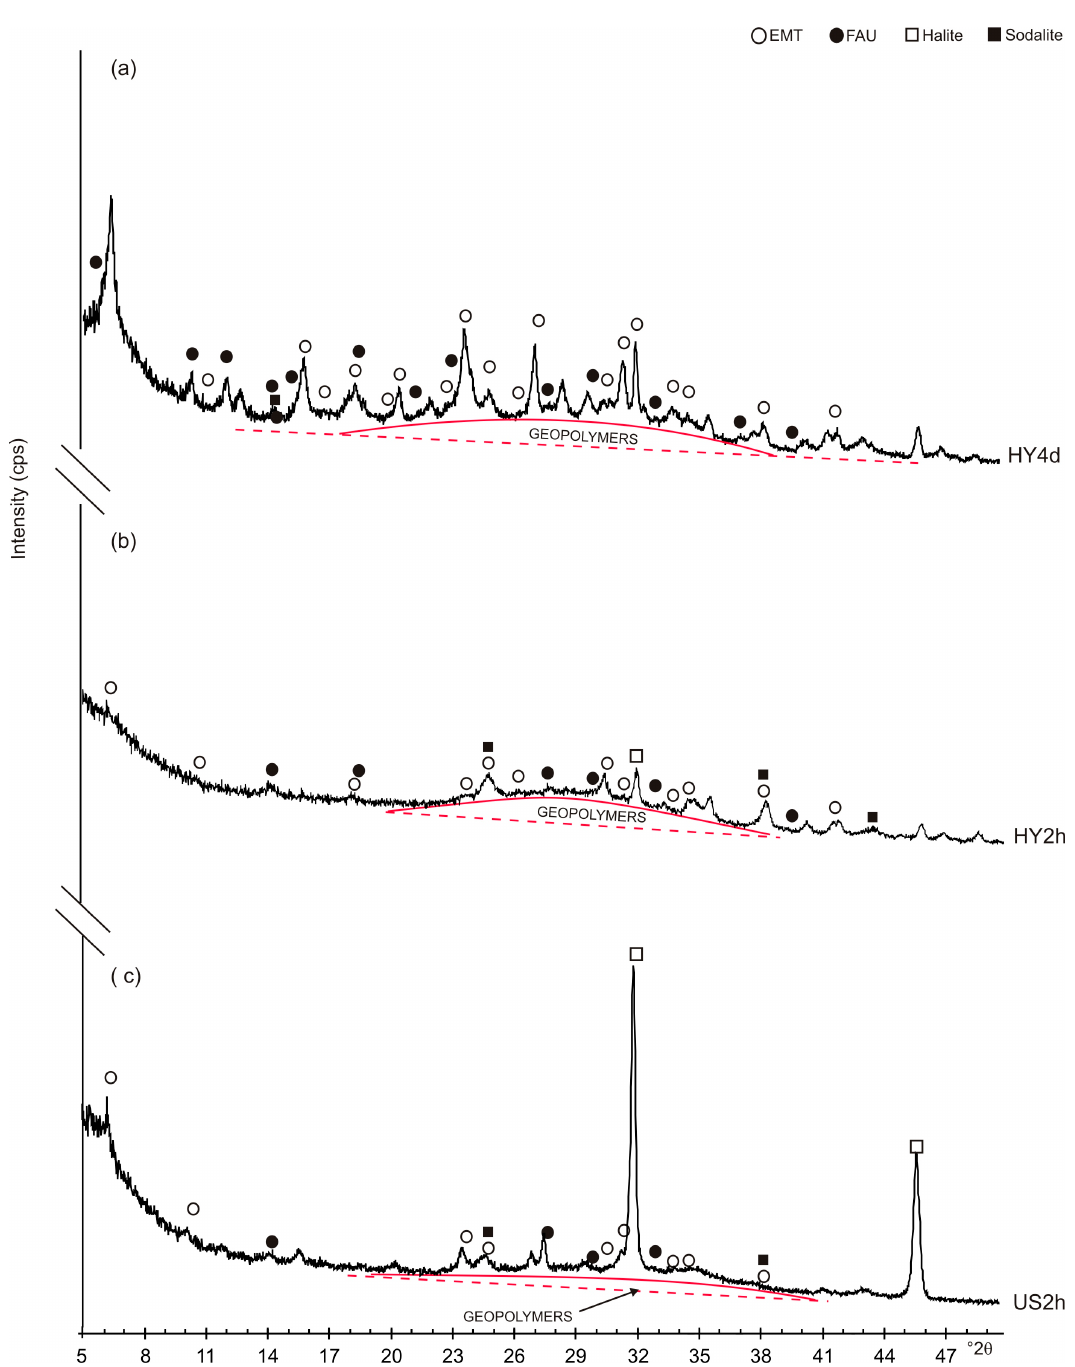
Figure 2. XRD patterns of the sample after: ( a ) conventional hydrothermal process at 60 °C for 4 days (HY4d); ( b ) hydrothermal water bath method for 2 h at 60 °C (HY2h) and ( c ) ultrasonic water bath (240 W; 35 kHz) for 2 h at 60 °C (US2h).